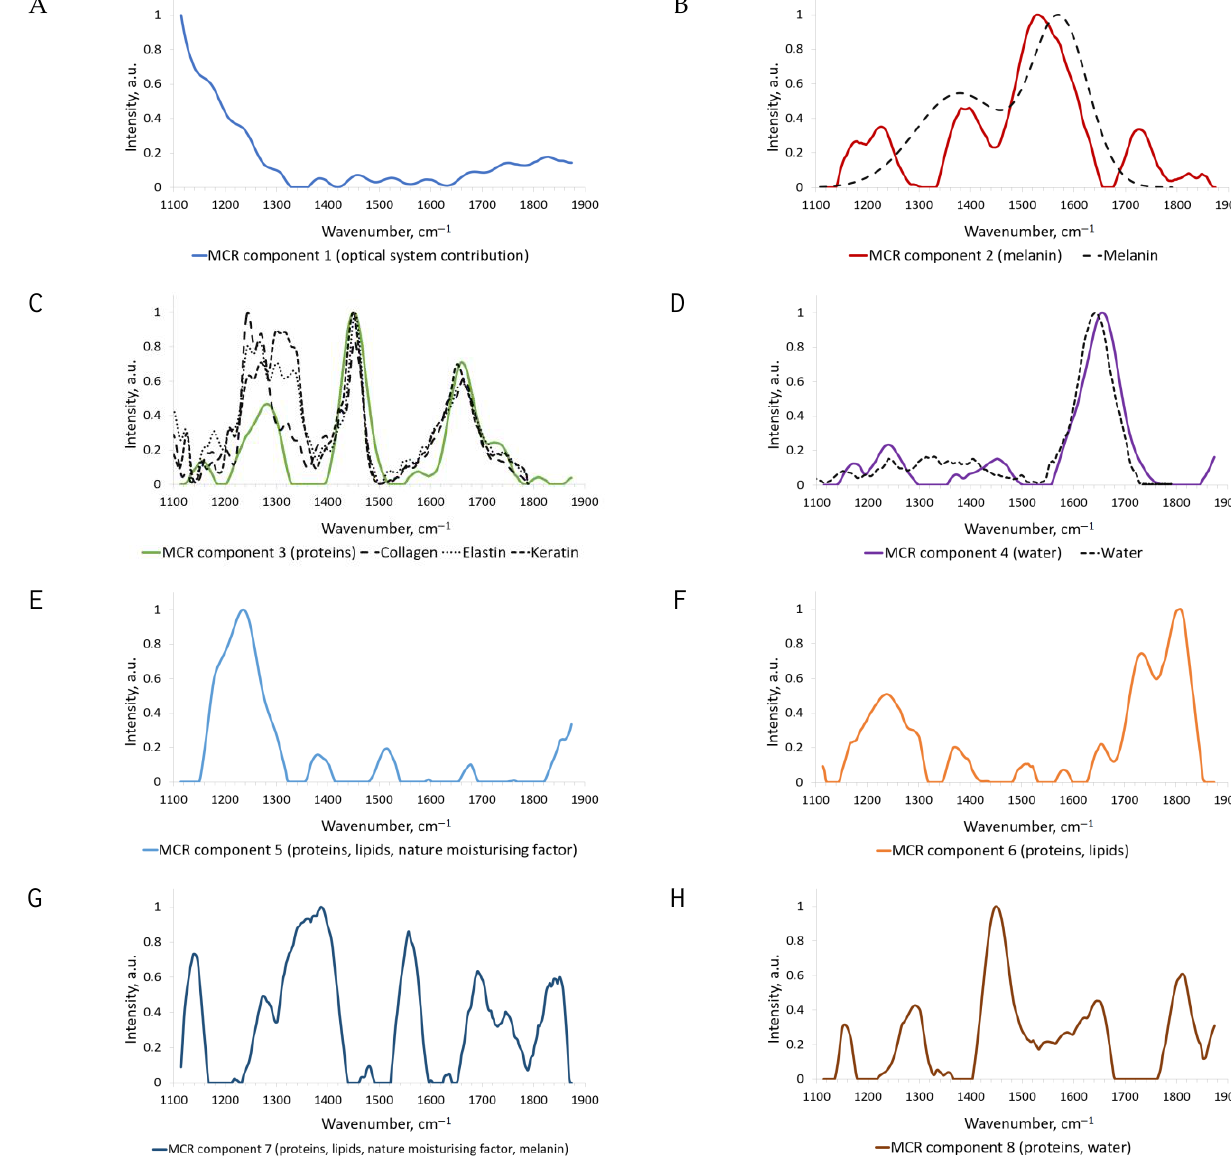
Figure 5. Raman spectra obtained by MCR-ALS analysis of the in vivo Raman spectra of skin (solid lines denote the spectra obtained in our study, dashed lines, the spectra obtained in [21]): ( A ) Component 1 (optical system contribution), ( B ) Component 2 (melanin), ( C ) Component 3 (proteins), ( D ) Component 4 (water), ( E ) Component 5 (proteins, lipids, nature moisturizing factor), ( F ) Component 6 (proteins, lipids), ( G ) Component 7 (proteins, lipids, nature moisturizing factor, melanin), ( H ) Component 8 (proteins, water).